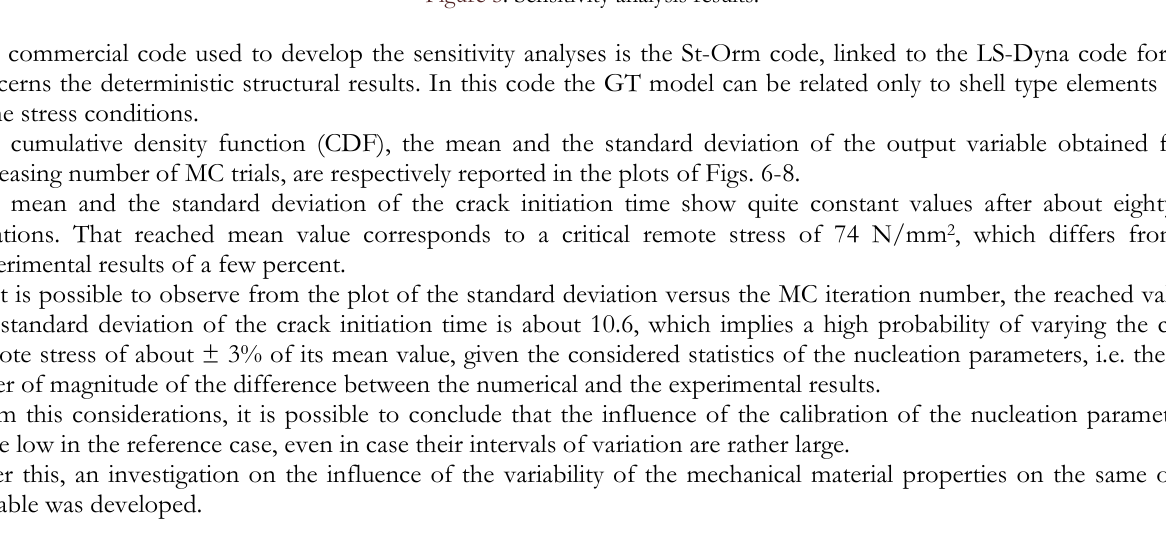
Figure 5: Sensitivity analysis results.